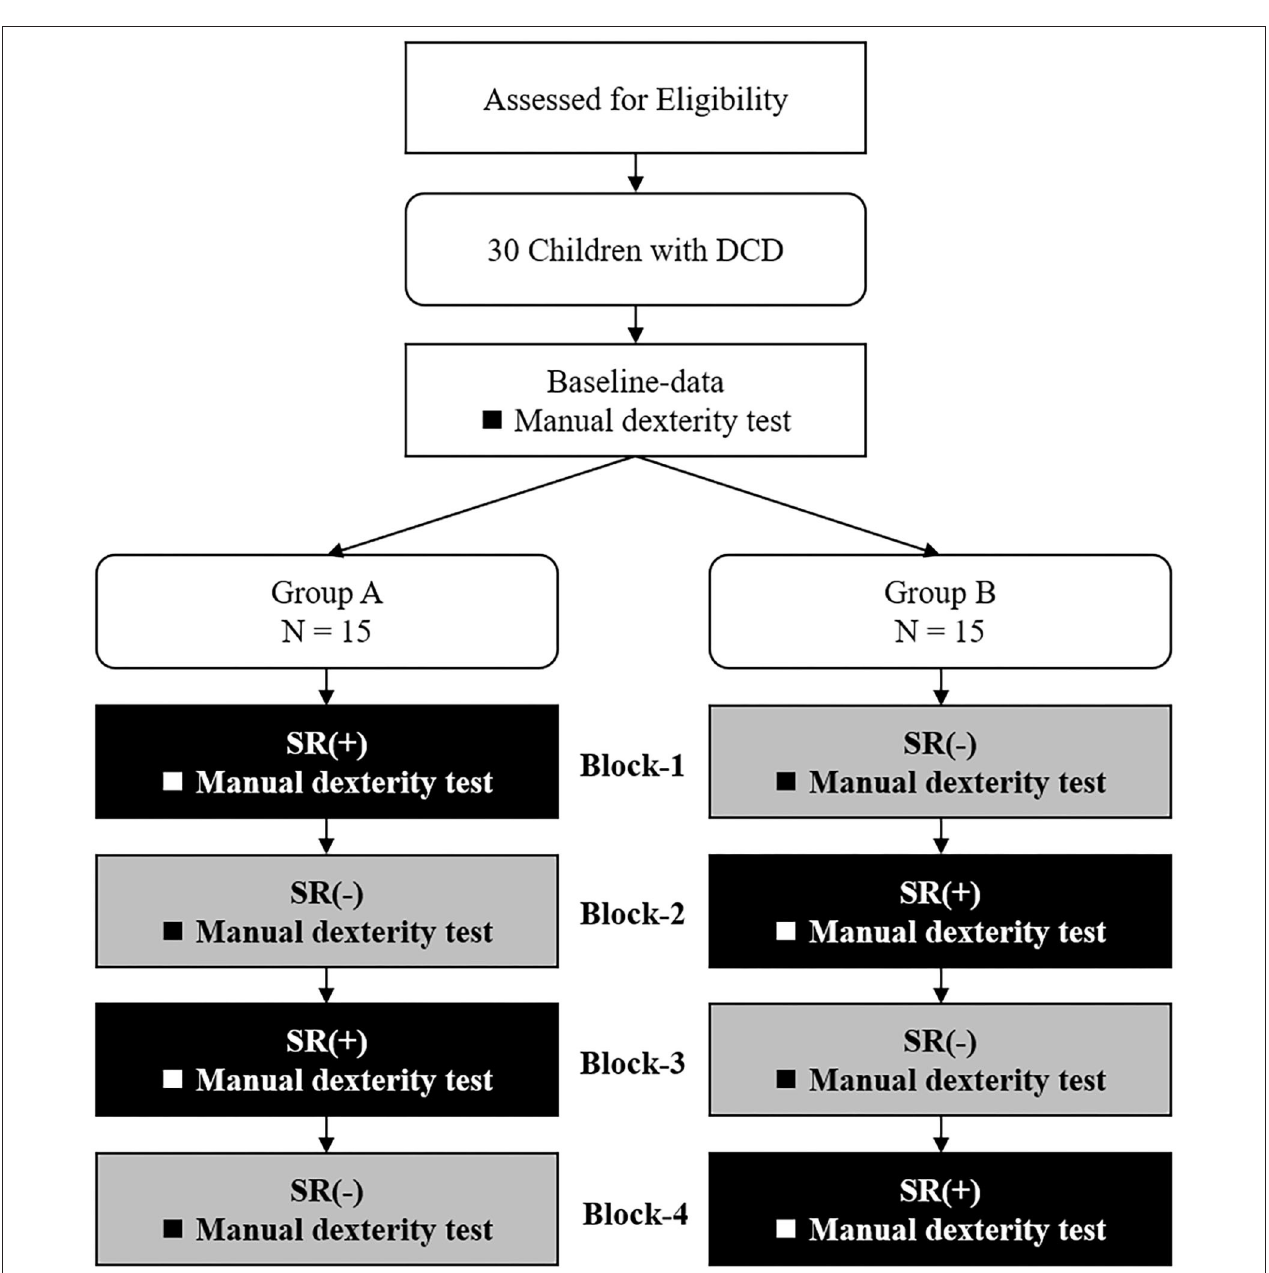
FIGURE 1 | Current experimental protocol. DCD, developmental coordination disorder; SR( + ), stochastic resonance-on condition; SR(-), stochastic resonance-off